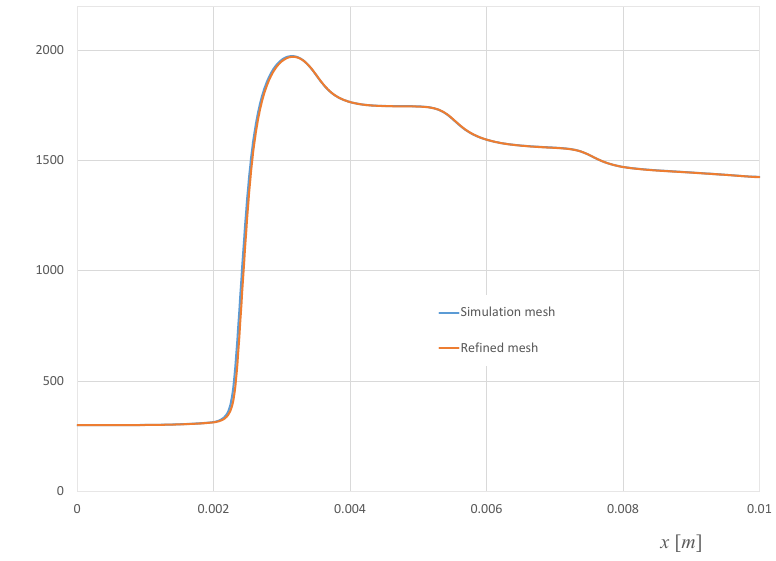
Figure 3. Temperature profile obtained in the mesh independence study using the conditions of case